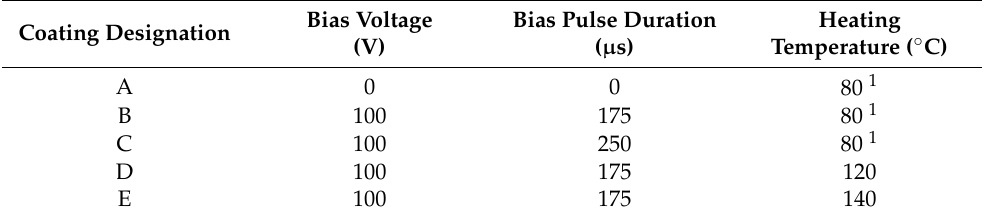
Table 1. Parameters used to synthesize different variants of laser-arc carbon coatings.